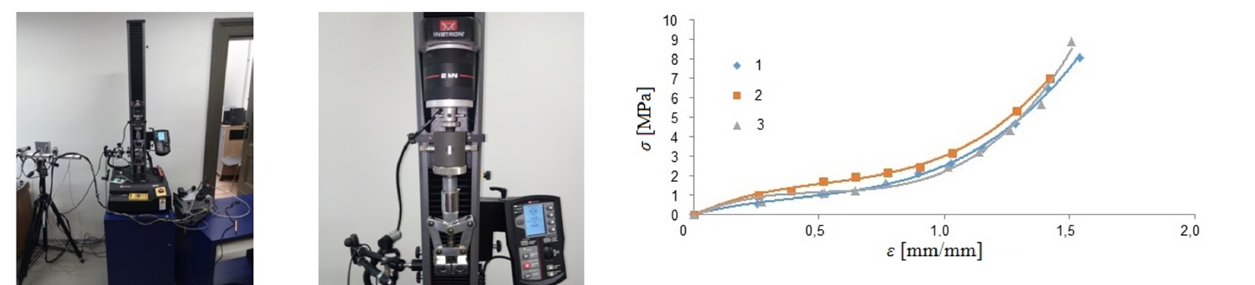
Figure 6: Uniaxial tension of the NBR 65 ∘ Sha